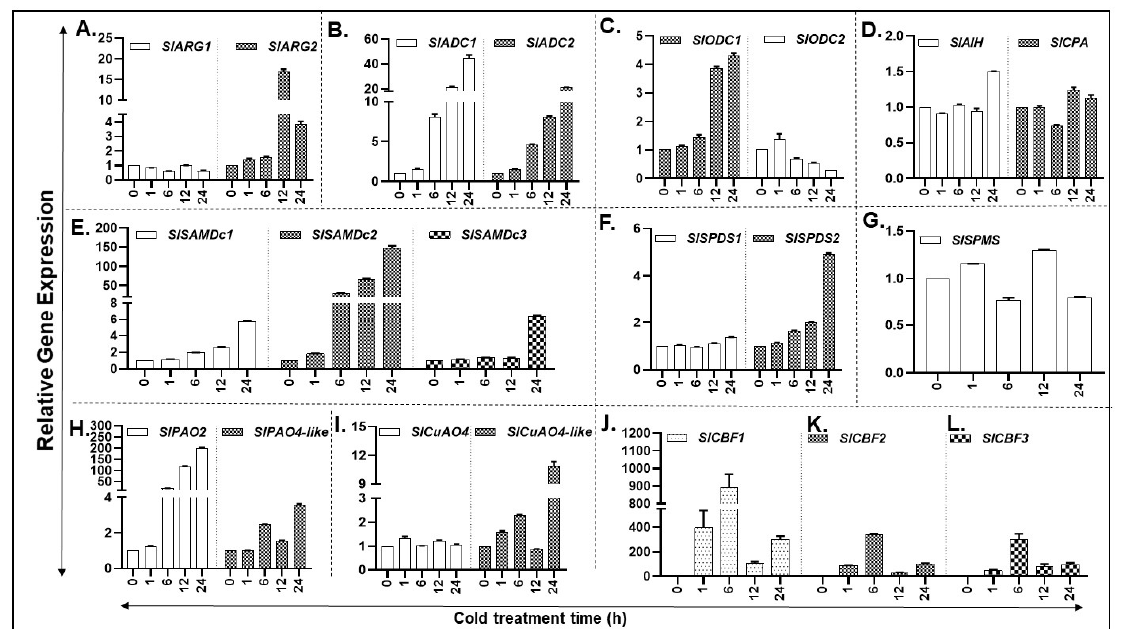
Figure 5. Cold-induced expression of PA metabolic pathway genes in tomato plants exposed to 4°C temperature. A., B., C., D. qRT-PCR led relative gene expression analysis of tomato leaf tissue reveals differential abundance of putrescine (PUT) biosynthesis genes ( SlARG1, 2 , SlADC1, 2 SlODC1, 2, SlAIH and SlCPA ); E., F., G . Spermidine (SPD) and Spermine (SPM) biosynthesis genes ( SlSAMDc1, 2, 3, SlSPDS1, 2 and SlSPMS ); H . and I . PA catabolic pathway genes ( SlPAO2 and SlPAO4-Like; SlCuAO and SlCuAO4-like ); J., K., L. Cold-responsive genes CBF1, 2 and 3. A minimum of three leaves were excised from three plants for each biological replicate. Mean data points and standard error of a minimum of three biological replicates are shown. Statistical significance (p-value) was derived using Graph prism pad program via Tukey test/t-test. SlUBI3 and SlTIP41 were used as reference genes.